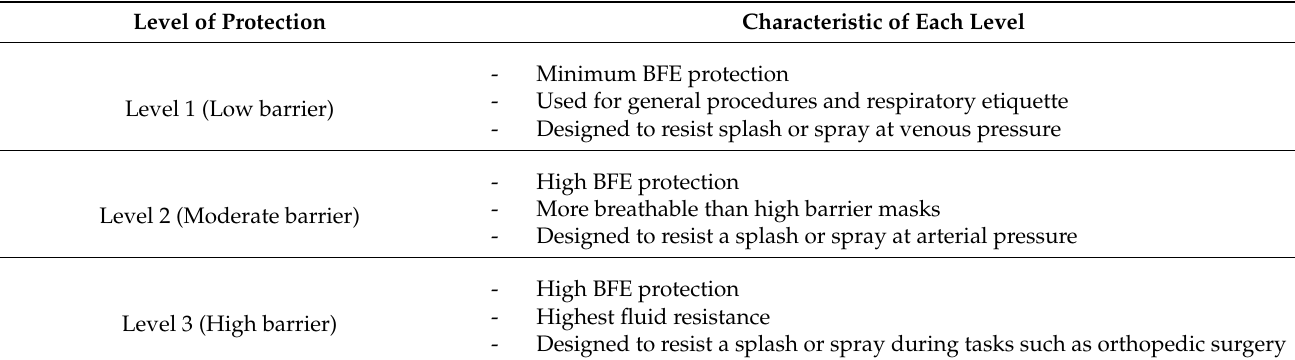
Table 3. ASTM F2100-11 levels of protection in SFMs.